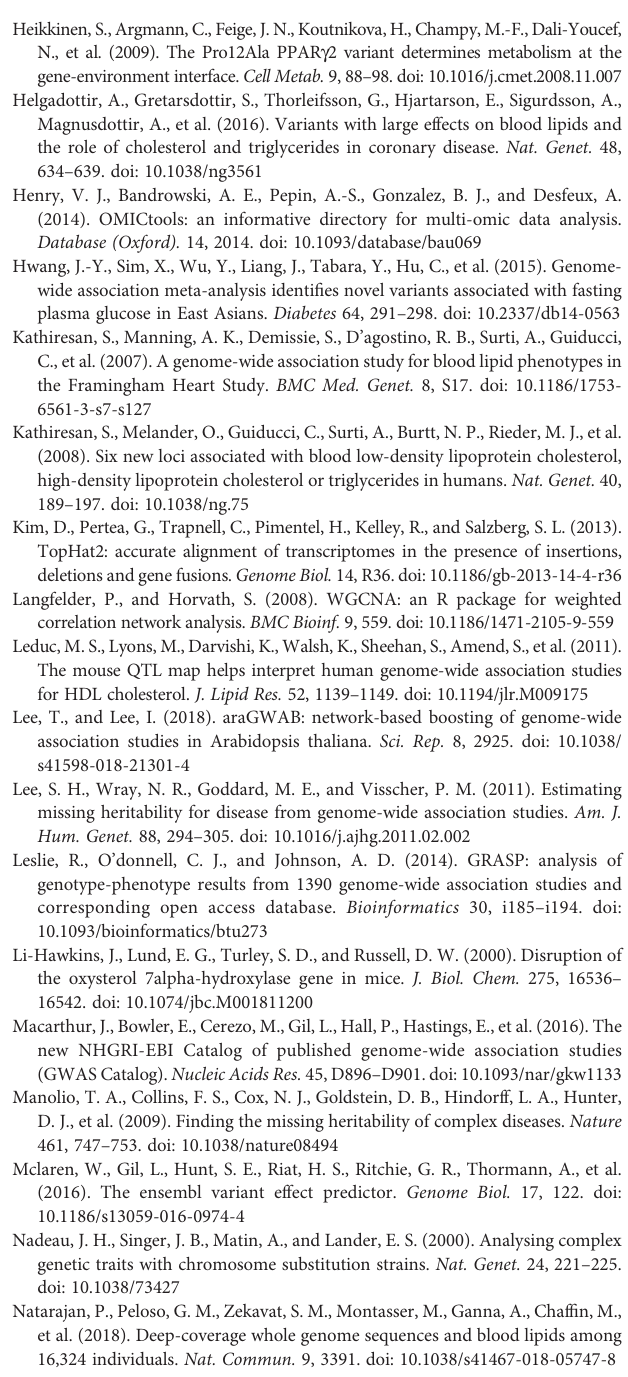
SUPPLEMENTARY FIGURE 1 | Heatmap of the candidate gene expression levels across the 22 mouse